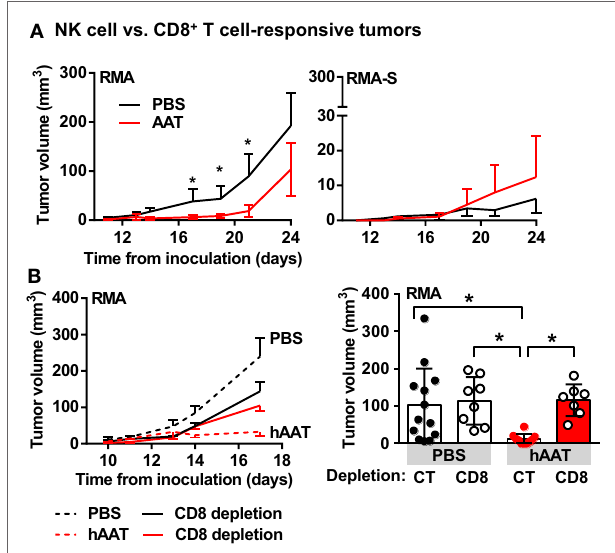
FigUre 3 | haaT-treated mice display inhibited development of rMa, but not rMa-s tumors . (a) C57BL/6 mice ( n = 8 per group) were pretreated with hAAT (2 mg per animal, i.p . ) 24 h prior to simultaneous inoculation with RMA cells to the right flank and RMA-S cells to the left flank (1 × 10 5 cells per animal, s.c.); hAAT was administered every third day afterward, and tumor sizes were determined routinely. (B) In vivo RMA inoculations ( n = 6 per group) were combined with depletion of CD8 + T cells, and tumor size was measured routinely. Graphs represent linear development of tumors as well as full scatter graph at day 17 post-inoculation. Mean ± SEM, * p < 0.05. Unpaired two-tailed Student’s t -test was employed to assess differences between